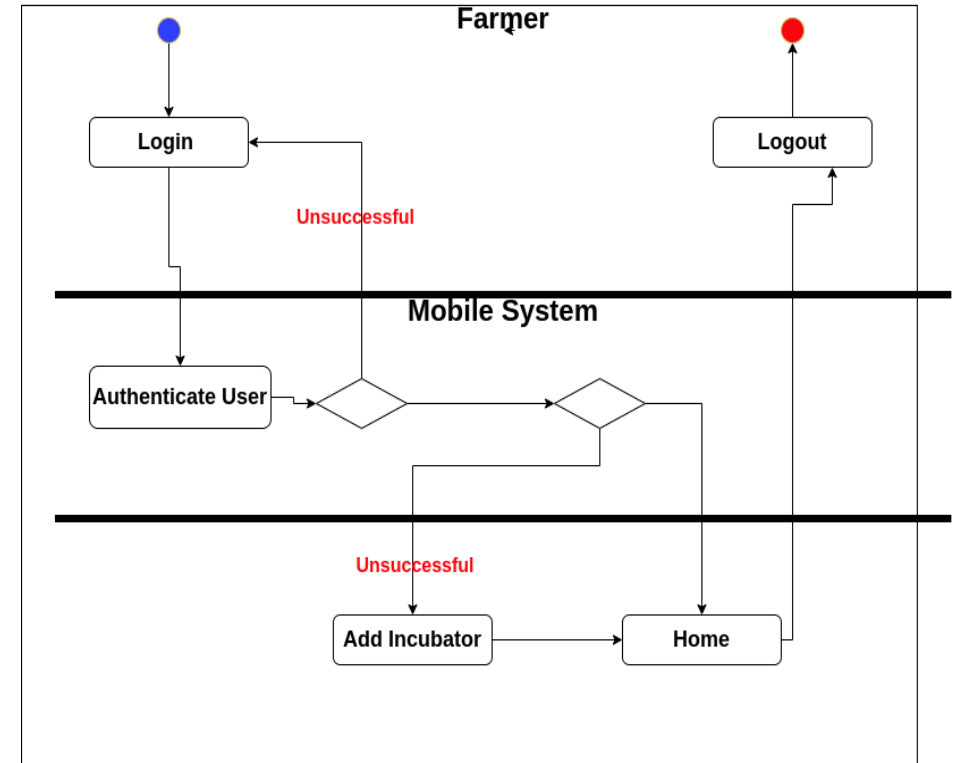
Figure 13. digiINCU activity diagram